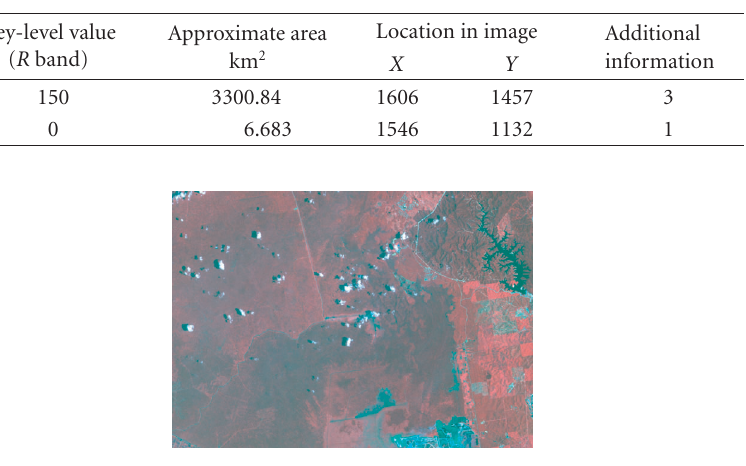
Figure 4.3. Image of area in peninsular Malaysia acquired on March 6, 1998. Scale is approximately 1 : 0 . 0003764.